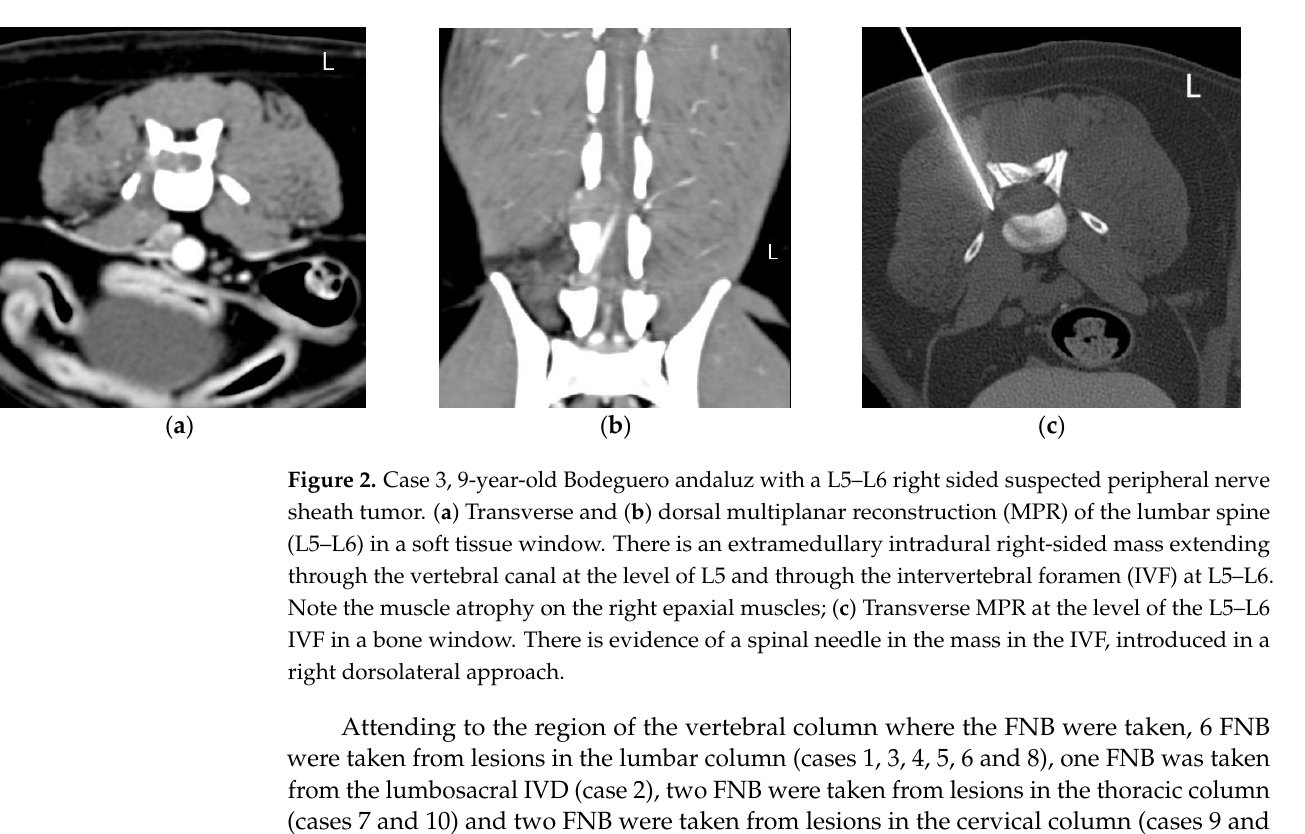
Figure 1. Case 2, 6-year-old Bullterrier with lumbosacral (LS) discospondylitis. ( a ) Sagittal multipla- nar reconstruction (MPR) of the LS region in a bone window. There is moderate narrowing of the intervertebral disk space (IVDS) and severe osteolysis of the caudal L7 and cranial S1 endplates, with moderate sclerosis and marked spondylosis deformans; ( b ) Transverse MPR of the LS IVDS in a bone window. There is evidence of a spinal needle in the intervertebral space, introduced in a left ventrolateral approach.